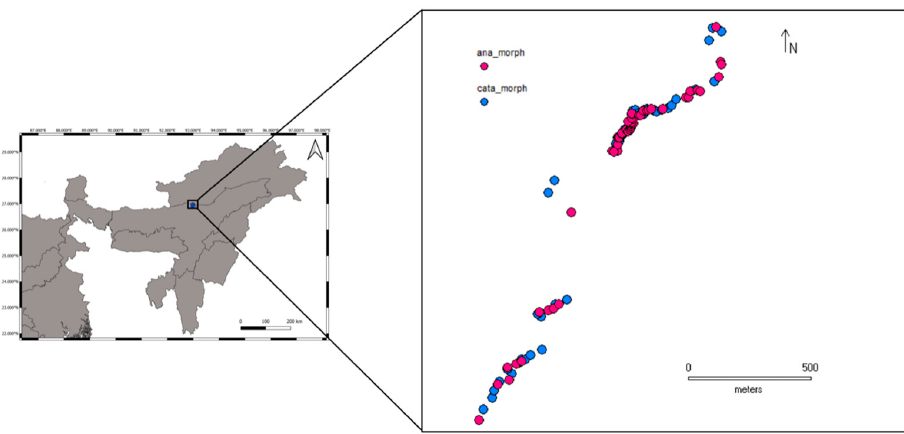
Figure 3. Sample collection map of the ana- and cata-morphs of Alpinia nigra from Pakke Tiger Reserve, Arunachal Pradesh, North-East India.